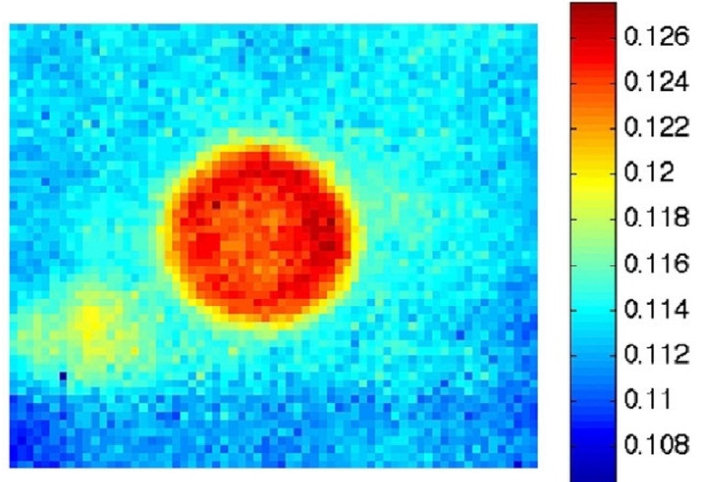
Figure 9. Wavelet shift factor N for which the defect location is best visible. Reprinted and adapted with permission from Ref. [53]. Copyright 1999, AITA.